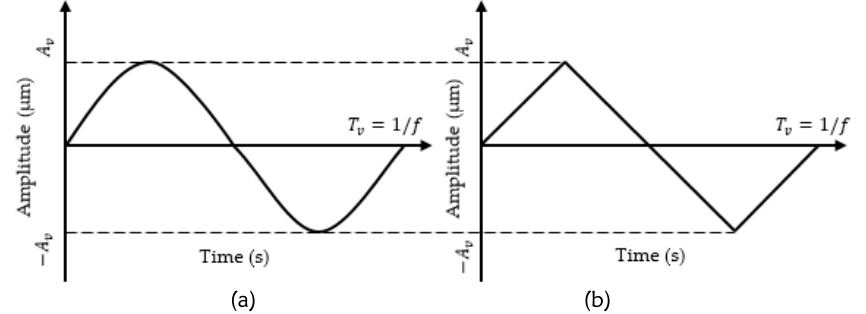
Figure 4 (a) Sine wave (b) Approximation of sine wave in Star